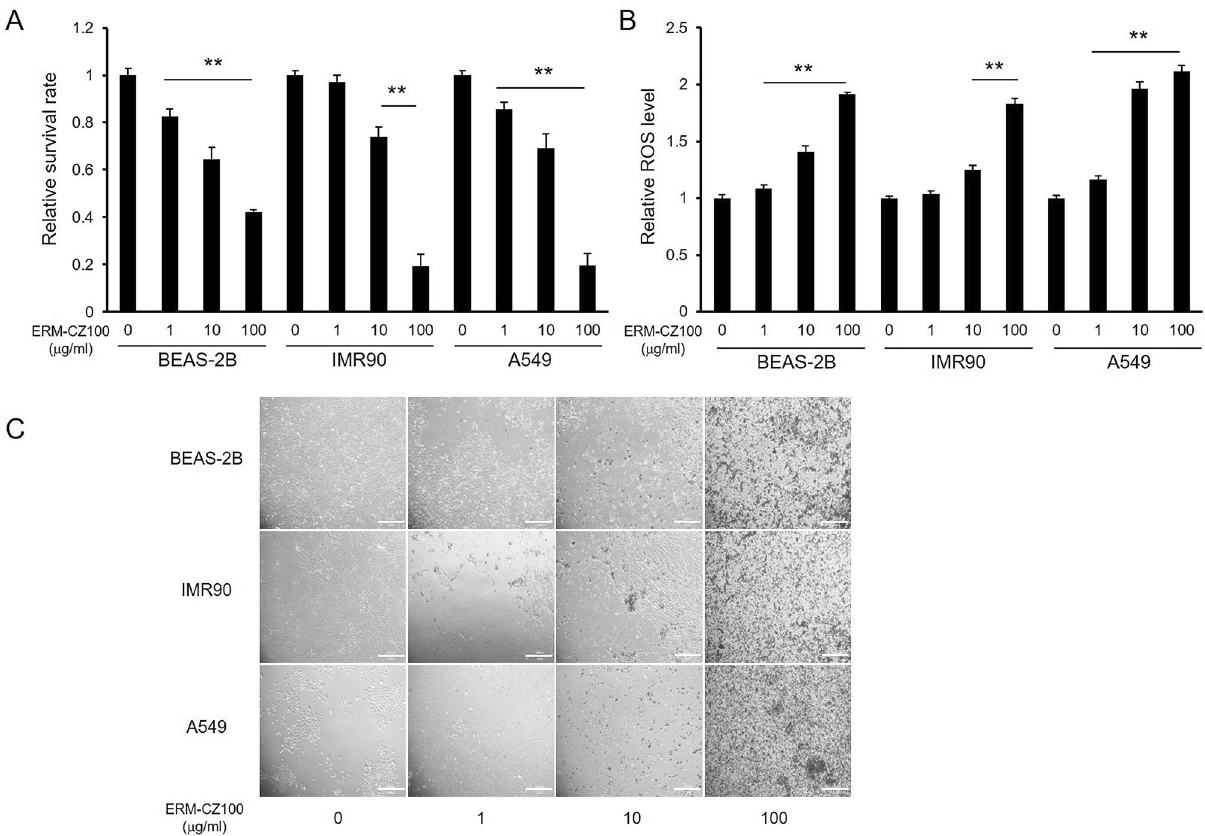
Figure 1. Effects of FDPs on airway and lung cells. ( A ) Cytotoxicity of FDPs toward BEAS-2B, IMR90, and A549 cells. ( B ) Intracellular ROS levels in FDP-stimulated BEAS-2B, IMR90, and A549 cells. ( C ) Cell morphology of FDP-treated cells. Cell viability was estimated by MTT assay, and intracellular ROS levels were determined by DCF-DA assay. The data are presented as the mean ± SD (N = 3). * p < 0.001 compared to the control group. Scale bars, 200